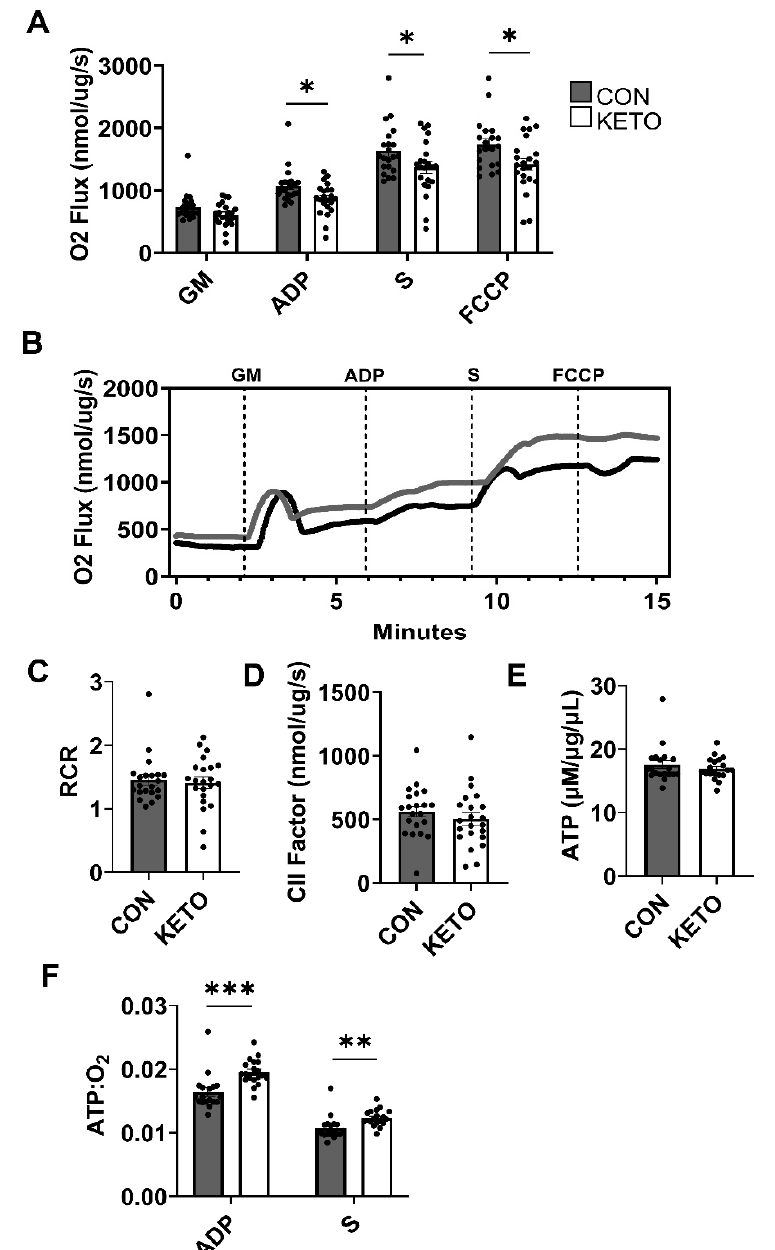
Figure 3. Ketogenic diet improves hippocampal mitochondrial efficiency. ( A ) Rates of mitochondrial oxygen consumption were measured via a substrate–uncoupler–inhibitor–titration protocol from hippocampi following an 8-week control or ketogenic diet. The protocol included the addition of glutamate and malate (GM), ADP, succinate (S), and carbonyl cyanide 4-(trifluoromethoxy) phenylhydrazone (FCCP). ( B ) Representative traces of oxygen consumption are plotted versus time with indicated substrate additions. ( C ) Respiratory control ratios (RCR) and ( D ) complex II-associated respiratory flux (CII factor) were calculated (CON, n = 21; KETO, n = 22) ( E ) ATP concentration and ( F ) ATP:O2 flux ratios were quantified (CON, n = 18; KETO, n = 19).* p < 0.05, ** p < 0.01, and *** p < 0.001.